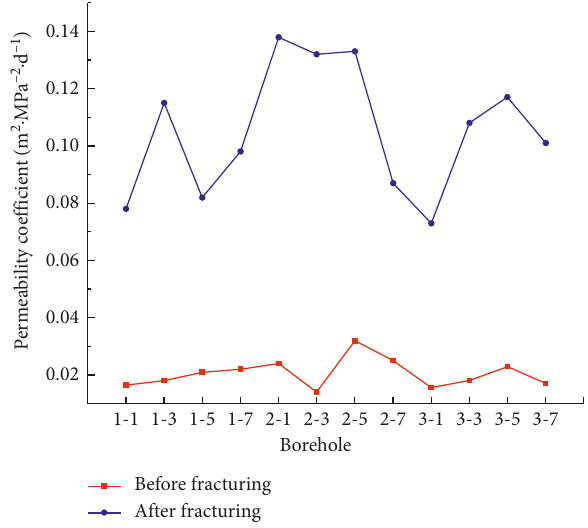
Figure 8: Changes of permeability coefficient of